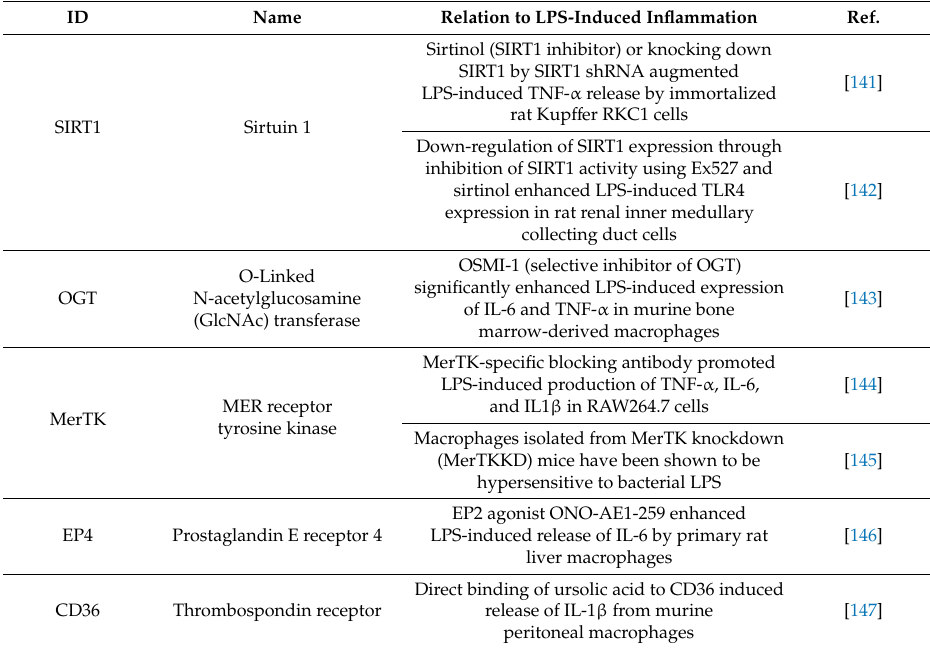
Table 1. Predicted probable targets * of